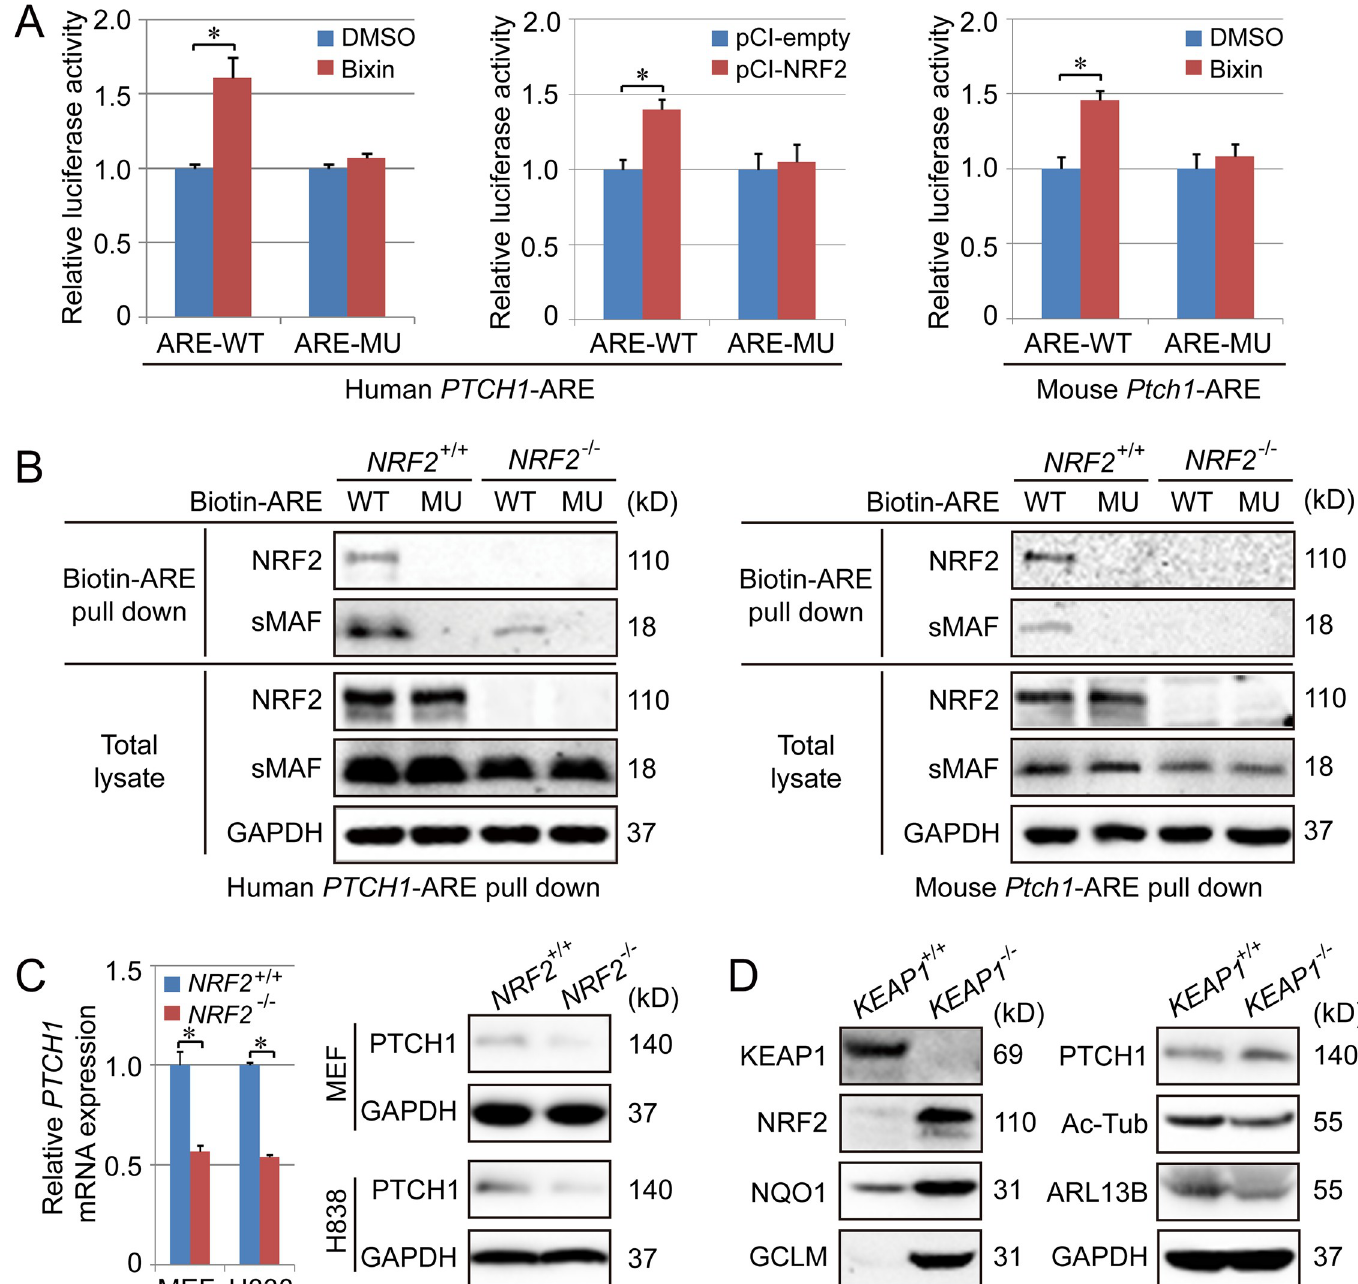
Fig 3. PTCH1 is an NRF2-target gene. (A) H1299 and MEF cells were transfected with pGL4.22 vector containing the promoter of human PTCH1 or the promoter of mouse Ptch1 and further treated with bixin (40 μ M) for 16 h, followed by a dual luciferase assay. (B) Biotinylated PTCH1 -ARE-WT and PTCH1 -ARE-MU were incubated with whole-cell lysates from H838 (for human PTCH1 -ARE) or MEF cells (for mouse Ptch1 -ARE), and ARE-bound proteins were pulled down by streptavidin beads and detected by immunoblot analysis with anti-NRF2 and anti-sMAF antibodies. (C) qPCR (left panel) and immunoblot (right panel) analysis of PTCH1 levels in the indicated NRF2 +/+ and NRF2 − / − cells. Relative quantification of immunoblot is shown in S6D Fig. (D) Immunoblot analysis of NRF2, NQO1, GCLM, Ac-Tub, ARL13B, and PTCH1 in KEAP1 +/+ and KEAP1 − / − H1299 cell lines. Relative quantification of immunoblot results is shown in S6E Fig. Results are expressed as mean ± SD. A t test was used to compare the various groups, and p < 0.05 was considered statistically significant. � p < 0.05 compared between the two groups. Ac-Tub, acetylated tubulin; ARE, antioxidant response element; ARL13B, ADP-ribosylation factor-like protein 13B; GAPDH, glyceraldehyde-3-phosphate dehydrogenase; GCLM, Glutamate-Cysteine Ligase Modifier Subunit; KEAP1, Kelch-like ECH-associated protein 1; MEF, mouse embryonic fibroblast; MU, mutation; NQO1, NAD(P)H Quinone Dehydrogenase 1; NRF2, nuclear factor-erythroid 2-like 2; PTCH1, Patched 1; sMAF, small MAF; WT, wild type.